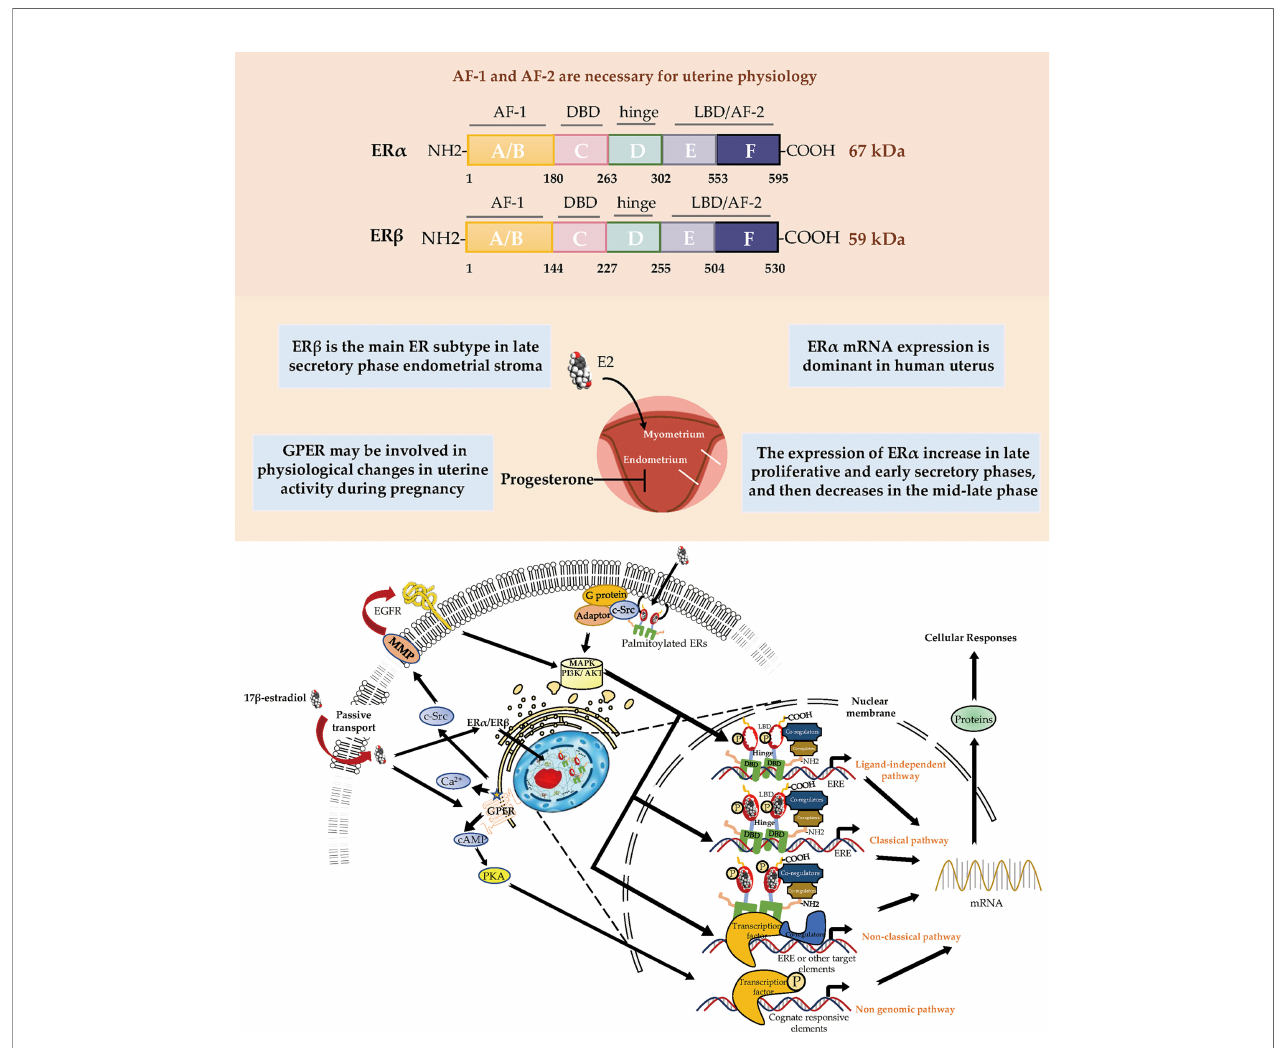
FIGURE 1 | Estrogen receptor-mediated signaling pathways in the endometrial. E2 promotes endometrial growth, while progesterone and other progesterone hormones block endometrial growth and promote differentiation. E2 mediates its biological response by binding to ERs via genomic and non-genomic pathways. There are 3 main mechanisms of genomic regulation. Firstly, in genomic regulation, E2 ligands passively enter the cells by diffusion. ER a and ER b are located in the cytosol. The binding of E2 to the ER promotes the formation of dimers, enters the nucleus and is directly binding to EREs, or to transcription factors which regulate transcription of its target genes. Secondly, the nonclassical pathway involves binding the E2-bound ER to TFs that are already bound to the DNA. The third mechanism is hormone-independent. The ER can regulate E2 responses by activating the signaling of growth factors via the phosphorylation of different serine (118/167) residues on the receptor. In non-genomic regulation, binding of E2 to ERs and GPR30 at the plasma membrane leads to various nongenomic responses, such as calcium signaling, PKC, and cAMP/PKA pathways. E2, 17 b -estradiol; ER, estrogen receptor; GPER, G-protein-coupled estrogen receptor; EGFR, epidermal growth factor receptor; PKA, protein kinase A; SF-1, steroidogenic factor 1; TNF a , tumor necrosis factor a ; PR, progesterone receptor; MAPK, mitogen-activated protein kinases; PI3K, phosphoinositide-3-kinase. ERE, estrogen response